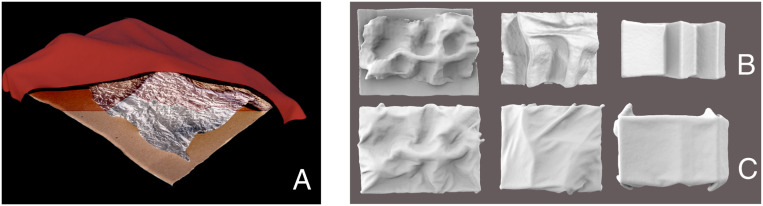
(A) Cross-section of 3D scan of stimulus A1, i.e., the first draping of base shape A. (B) Renderings of the three base shapes A to C (left to right), as presented in Experiment 2. (C) Renderings of example drapings of the three base objects, as used in Experiment 2 (from left to right: A2, B4, C1). For the complete stimulus set, see SI Appendix, Fig. S2.